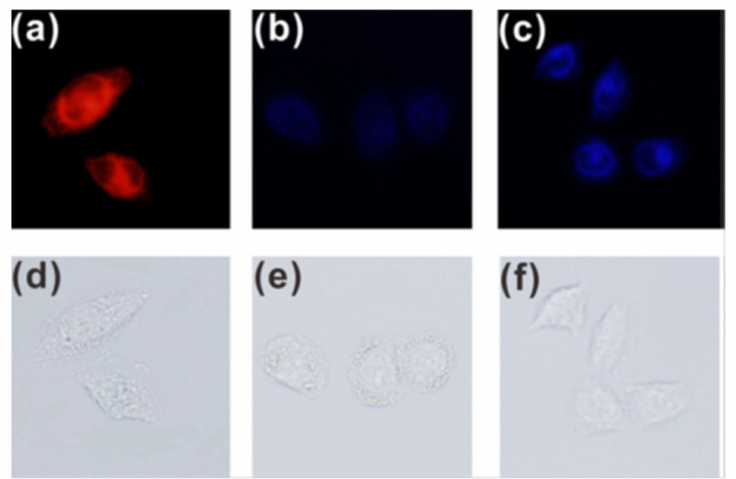
Figure 13. Fluorescence images of Hela cells incubated with probe 5 (10 µ M) before ( a , d ) and after being treated with ClO − (10 µ M) ( b , e ) and ClO − (50 µ M) ( c , f ) for 2 h [40]. Endogenous ClO − in RAW 264.7 live cells was obtained by PMA (phorbol myristate acetate) [41]. As shown in Figure 14, red fluorescence was observed when the RAW 264.7 cells were incubated only with probe 5 . However, when incubated with 2 mg/mL PMA and 5 , the cells displayed blue